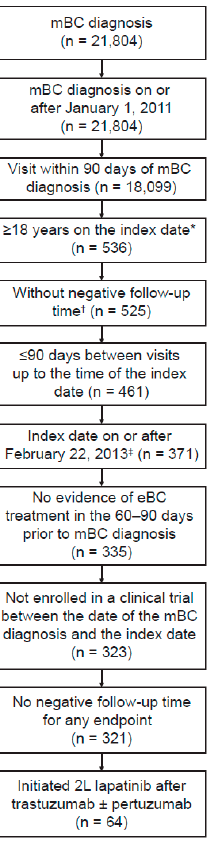
Figure A1. Patient flow diagram for the primary and secondary cohorts. a Date on or prior to 31 December 2019 that treatment with T-DM1 was initiated. b Death prior to the mBC diagnosis date. c Date T-DM1 was approved by the US Food and Drug Administration. 1L = first line; 2L = second line; eBC = early breast cancer; mBC = metastatic breast cancer; pts = patients; T-DM1 = trastuzumab emtansine.